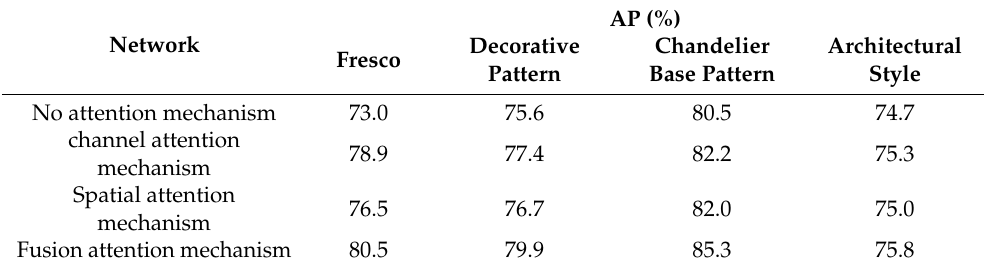
Table 3. Ablation experiment